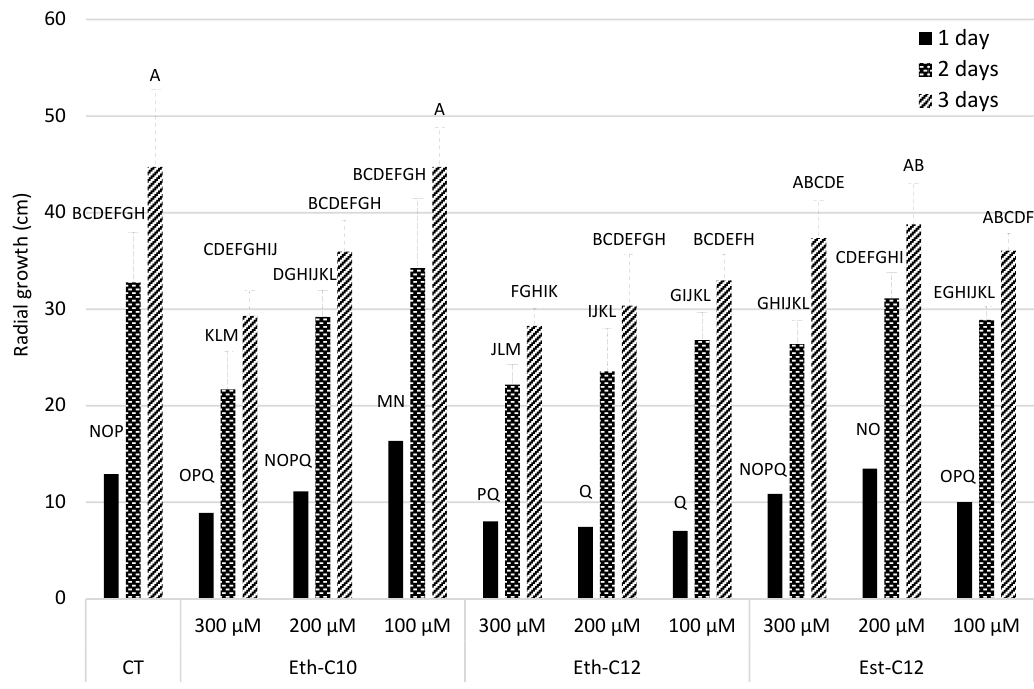
Figure 5. Radial growth surface (cm²) of a mycelium of B. cinerea growing for 1 day evaluated after 1, 2 and 3 days of growth in absence (CT-DMSO 0.1%) or in presence of smRLs (Eth-C10, Eth-C12 and Est-C12). Different letters indicate significant difference among all the means, according to a repeated-measures ANOVA followed by a Tukey-HSD post-hoc test ( p ≤ 0.05).